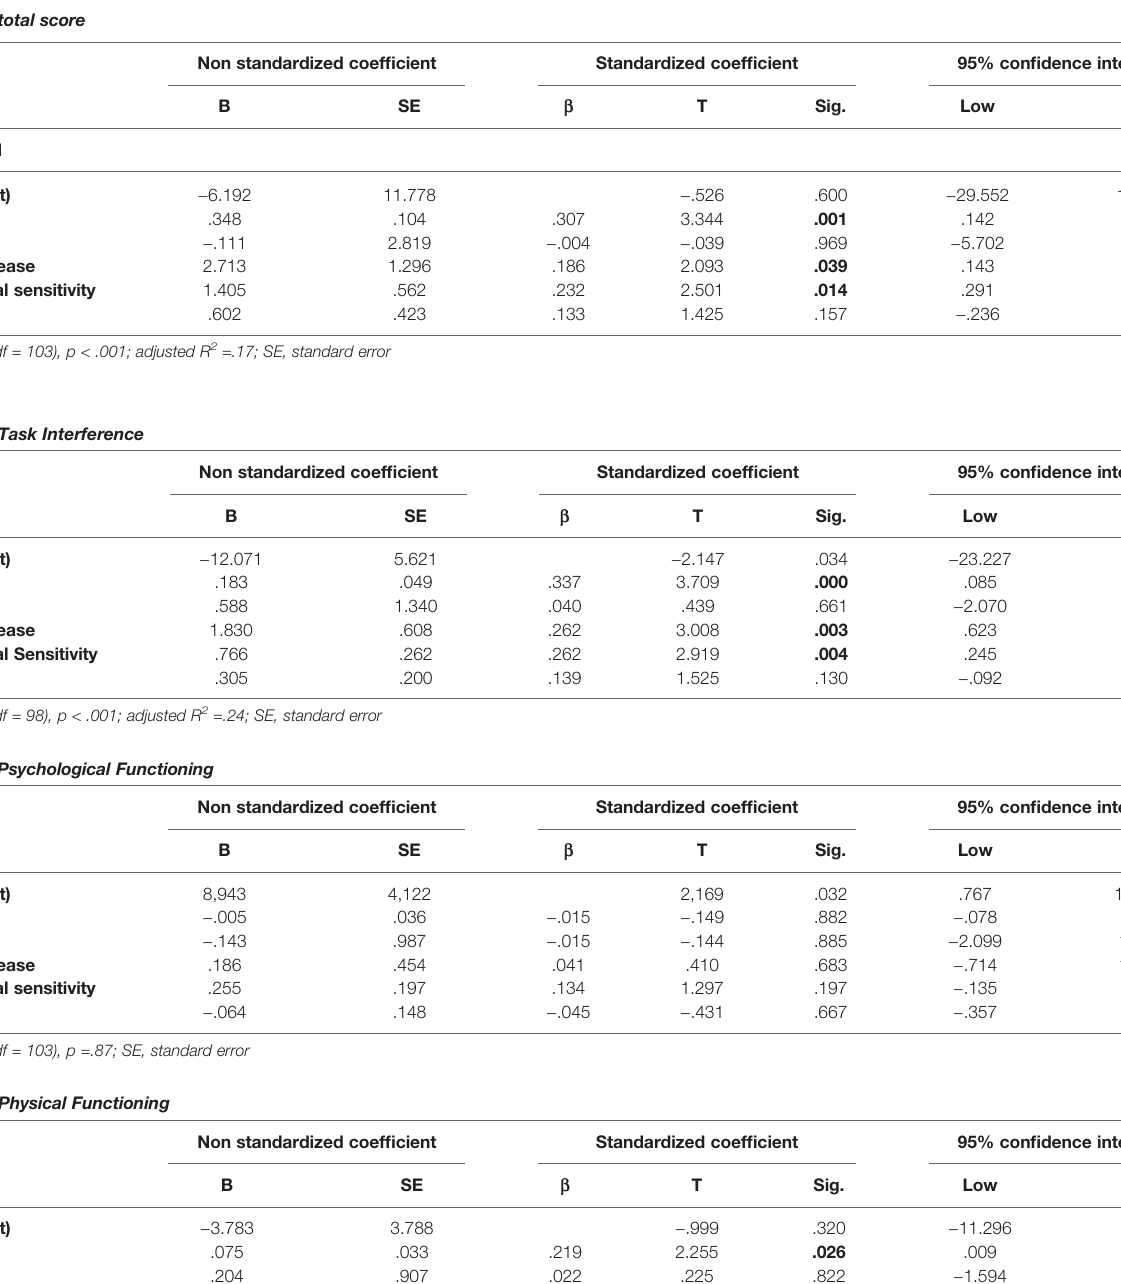
TABLE 6 | Regression analyses with PQLS total and subscale scores as dependent